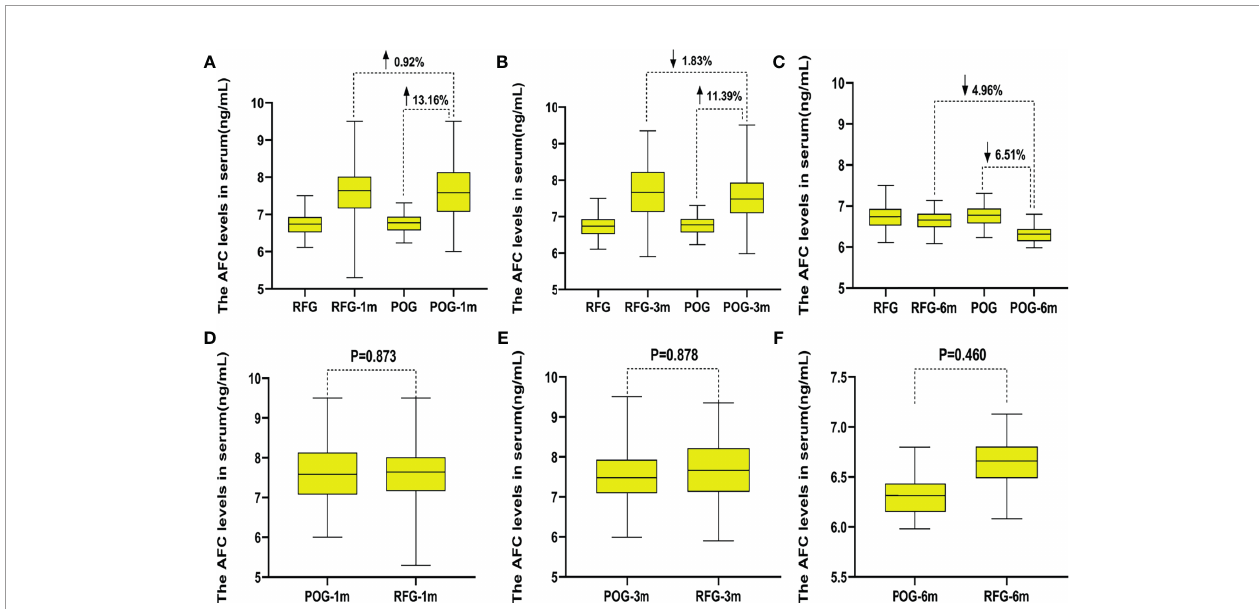
FIGURE 2 | The changes of the antral follicle count (AFC) in the two groups. Compared with preoperative, the increased AFC count of postoperative observation group (POG) in the ovary cyst side after the fi rst postoperative month was 13.16%. Compared with the AFC count of referent group (RFG) in the same ovary side, the increased rate of AFC count of POG in the ovary cyst side after the fi rst postoperative month was 0.92% (A) . Compared with preoperative, the increased AFC count of POG in the ovary cyst side after third postoperative month was 11.39%. Compared with the AFC count of RFG in the same ovary side, the declined AFC count of POG in the cyst ovary side after the third postoperative month was 1.83% (B) . Compared with preoperative, the declined AFC count of POG in the ovary cyst side after the sixth postoperative month was 6.51%. Compared with the AFC count of RFG in the same ovary side, the increased AFC count of POG in the ovary cyst side after the sixth postoperative month was 4.96% (C) . The AFC of the cyst showed no signi fi cant difference in POG when compared with that in RFG in the same side ovary in the fi rst, third, and sixth month postoperatively (p = 0.873, p = 0.878, p = 0.460, respectively) (D –